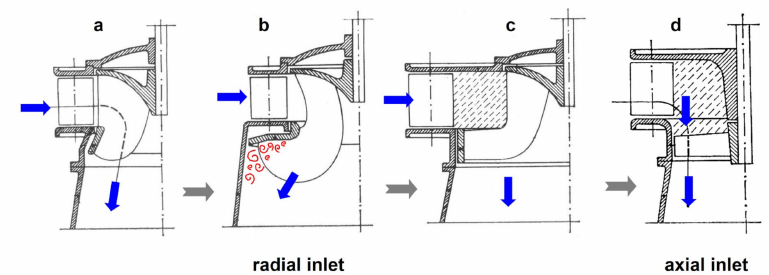
Figure 2. Development of impeller shapes of a specific high-speed turbine. ( a ) variant a; ( b ) variant b; ( c ) variant c; ( d ) variant d. Source: [4].